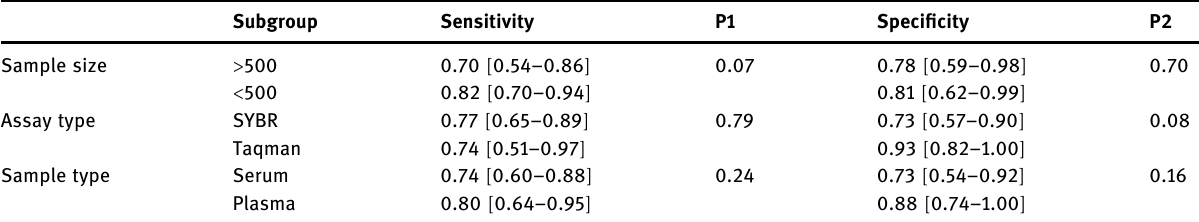
Table 4: Subgroup analysis of the diagnostic value of miR - 92a in gastric cancer Subgroup